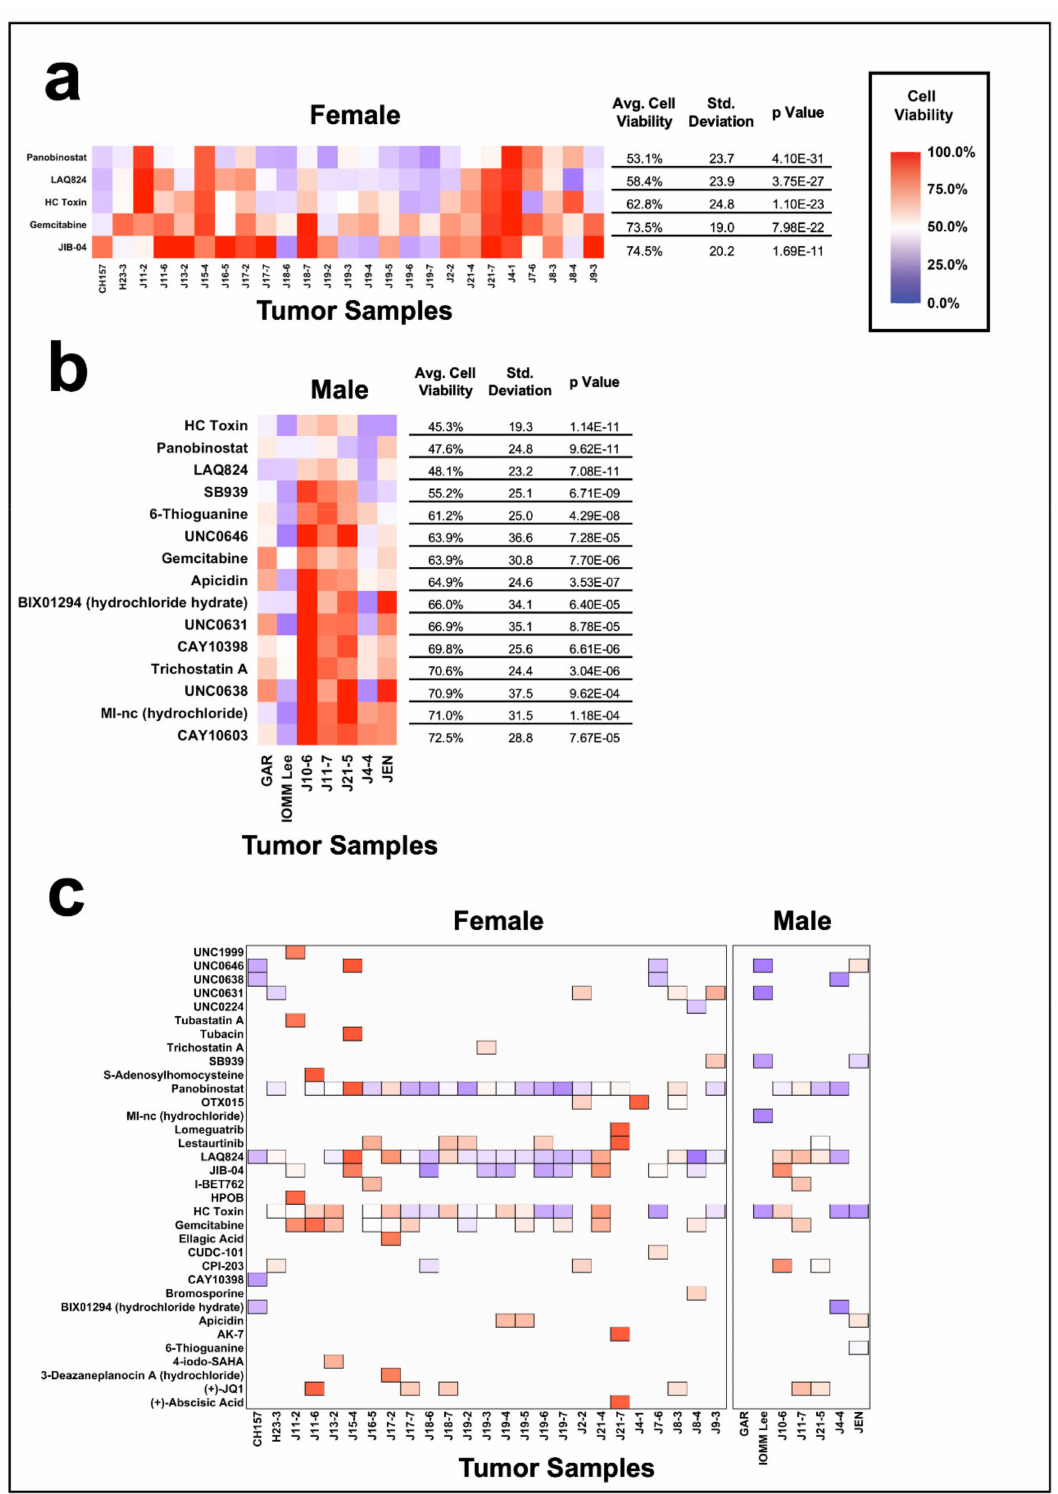
Figure 6. Comparison of the meningioma cohort by patient gender. Heat maps of broadly effective compounds, separated by tumors originating from ( a ) female patients and ( b ) male patients. Broadly effective compounds for meningiomas derived from female and male patients are identified as compounds that reduce the average cell viability of the group to 80% or less and have a p value of less than 0.05. ( c ) Heat map of the top five most effective epigenetic compounds, separated by female and male patients. The top five compounds are displayed as filled tiles in the heat map, while compounds that were not in the top five remain as white